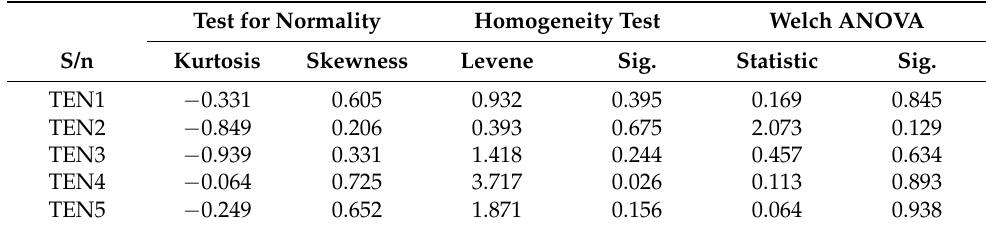
Table 6. One-way ANOVA for H&S considerations at the tendering stage.